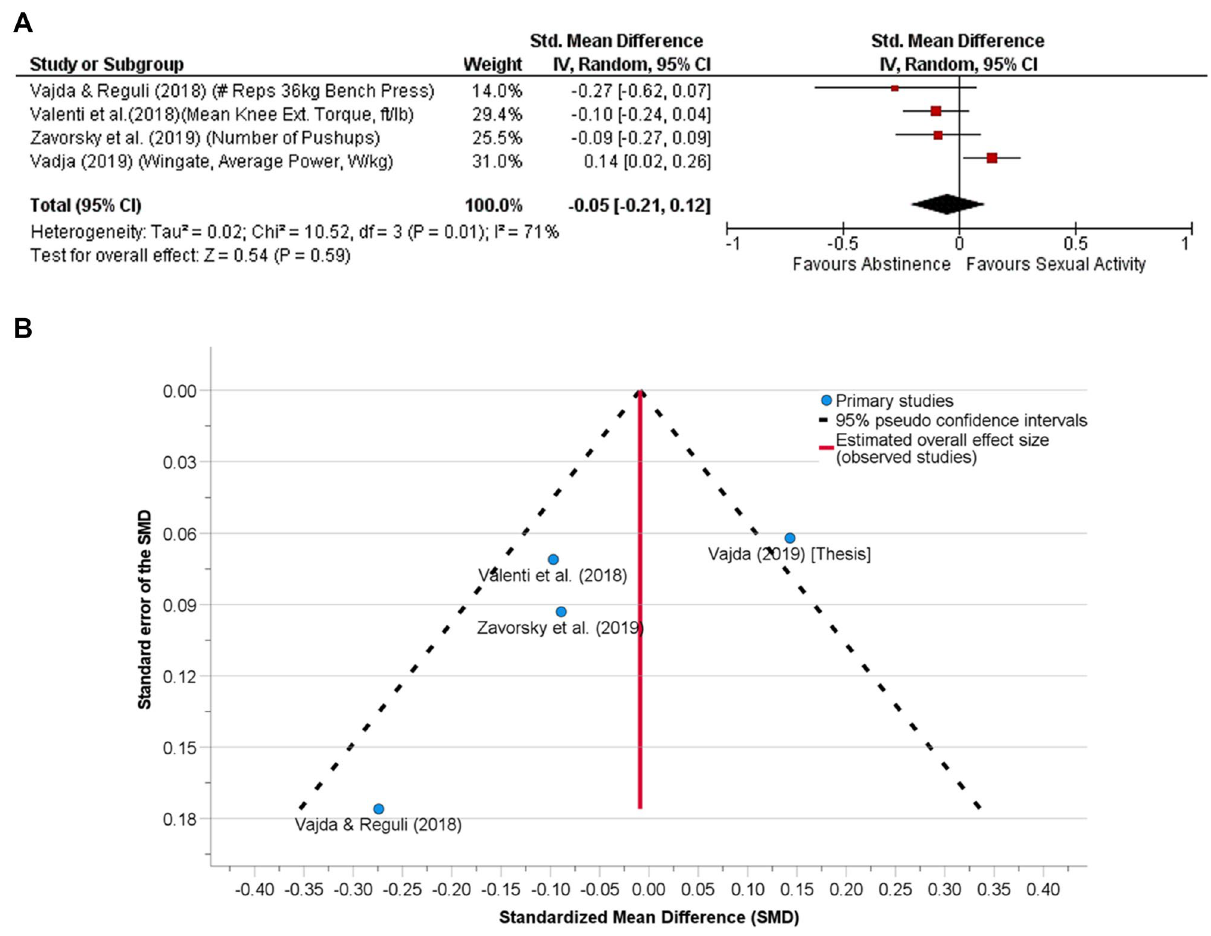
Figure 2. (A) The effect of sexual activity that occurred 7.5–24 h before assessing musculoskeletal fitness is displayed using a Forest Plot. The data demonstrate that musculoskeletal endurance is unlikely affected by prior sexual activity or abstinence. That is, both experimental and control conditions provide similar test results. A random-effects model was used. No other adjustments were made here. There was substantial heterogeneity between studies ( p = 0.01). (B) Funnel plot for the detection of publication bias in ( A ). Egger’s random effects meta-regression-based test was used with the Knapp-Hartung SE adjustment. There was no funnel plot asymmetry (Intercept = 0.24, SE = 0.418, t = 1.36, p = 0.31, 95% CI of the coefficient = − 0.51 to 10.99); Standard error of the effect size = − 3.20, SE = 1.97, t = − 1.62, p = 0.25, 95% CI − 11.69 to 5.29). After adjusting for the missing studies, the SMD (SE of the SMD) was − 0.01 (0.09) [95% CI − 0.25 to 0.23, p = 0.92], demonstrating that neither abstinence nor sexual activity prior to exercise affects musculoskeletal fitness